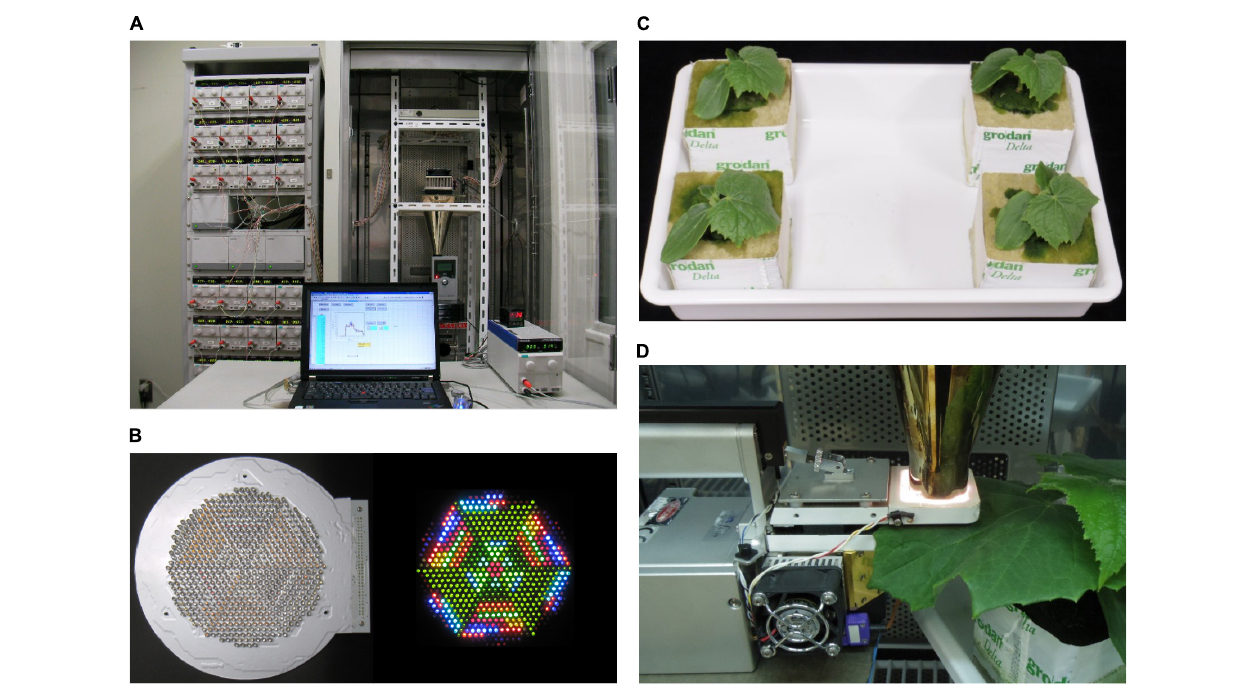
FIGURE 1 | (A) The LED-artificial sunlight source (LASS) system. Left: 32 DC power supplies, a DC power supply controller, and three controller expansion units in a rack; right: the light source unit comprising an LED module, a cooling unit of the LED temperature control system, and a hollow conical reflection condenser, and a spectroradiometer in a temperature-controlled chamber; bottom: a DC power supply and a PID controller of the LED temperature control system and a laptop computer. (B) Bottom views of the LED module when all LEDs are off (left) and on (right). (C) 13-day-old cucumber seedlings grown under phosphor-converted white LED light. (D) During the measurement of net photosynthetic rate ( P n ), a part of a cucumber leaf was sandwiched in a leaf chamber of the portable photosynthesis system, and the surface of transparent film covering the top of the leaf chamber was placed in contact with the light outlet of the hollow conical reflection condenser of the LASS system.